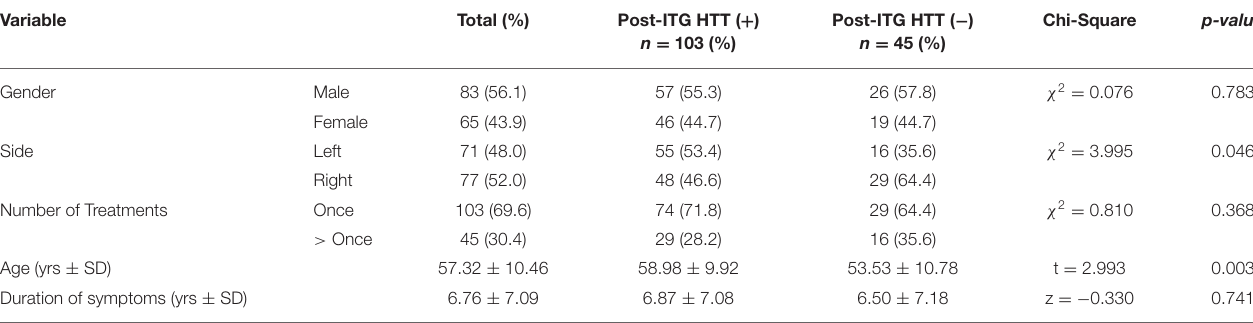
TABLE 2 | Baseline characteristics and head thrust response (%) of patients with negative HTT pretreatment.